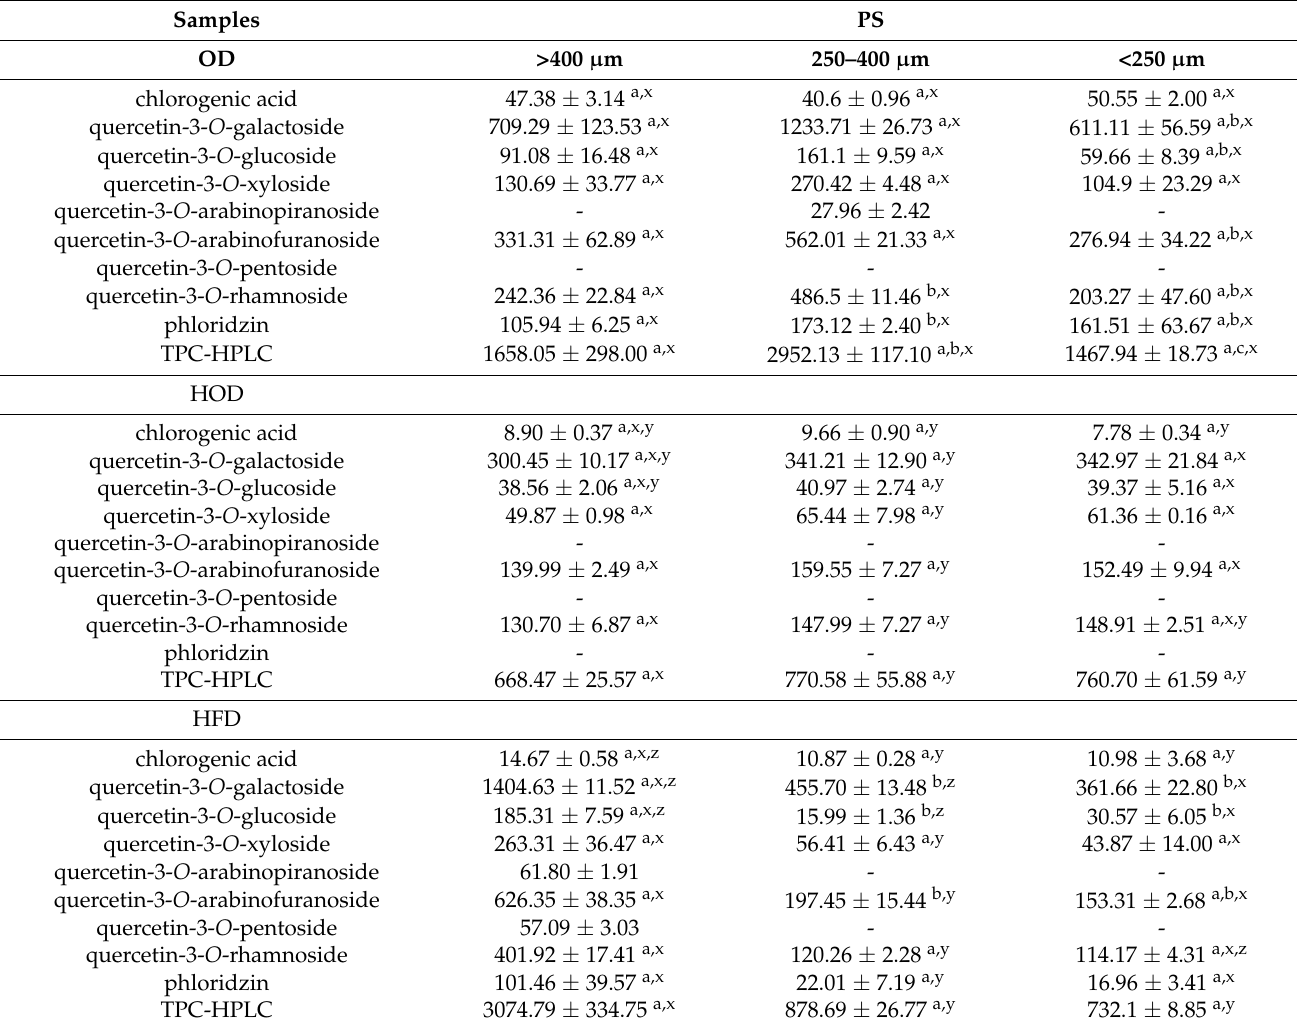
Table 4. Content ( µ g/g, DW) of phenol compounds of AP samples subjected to different drying treatments (OD, HOD, HFD) with different particle size (PS: >400 µ m; 250–400 µ m; <250 µ